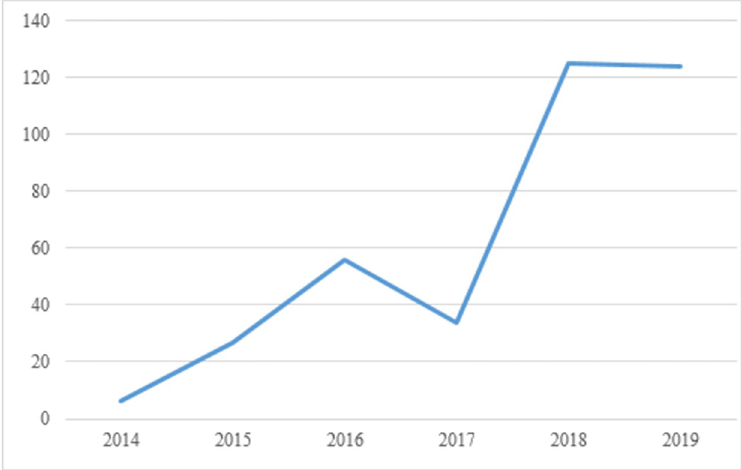
Fig 1. The number of defaults of Chinese corporate bonds from 2014 to 2019. Source: Wind Economic Database. https://doi.org/10.1371/journal.pone.0259759.g001 Table 1. The scale and the proportion of different credit ratings of corporate bonds.